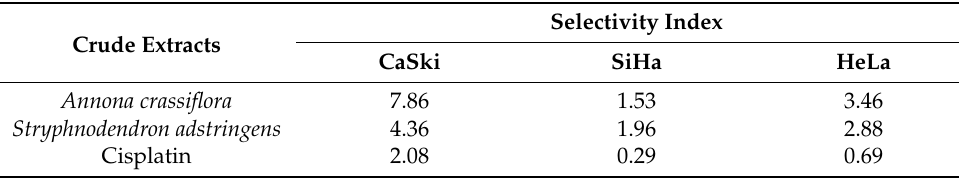
Table 2. Selectivity index values of two crude extracts in human cell lines.